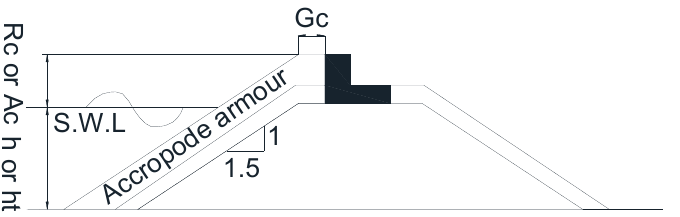
Figure 1. Schematic diagram of the breakwater with an armor layer of Accropode.